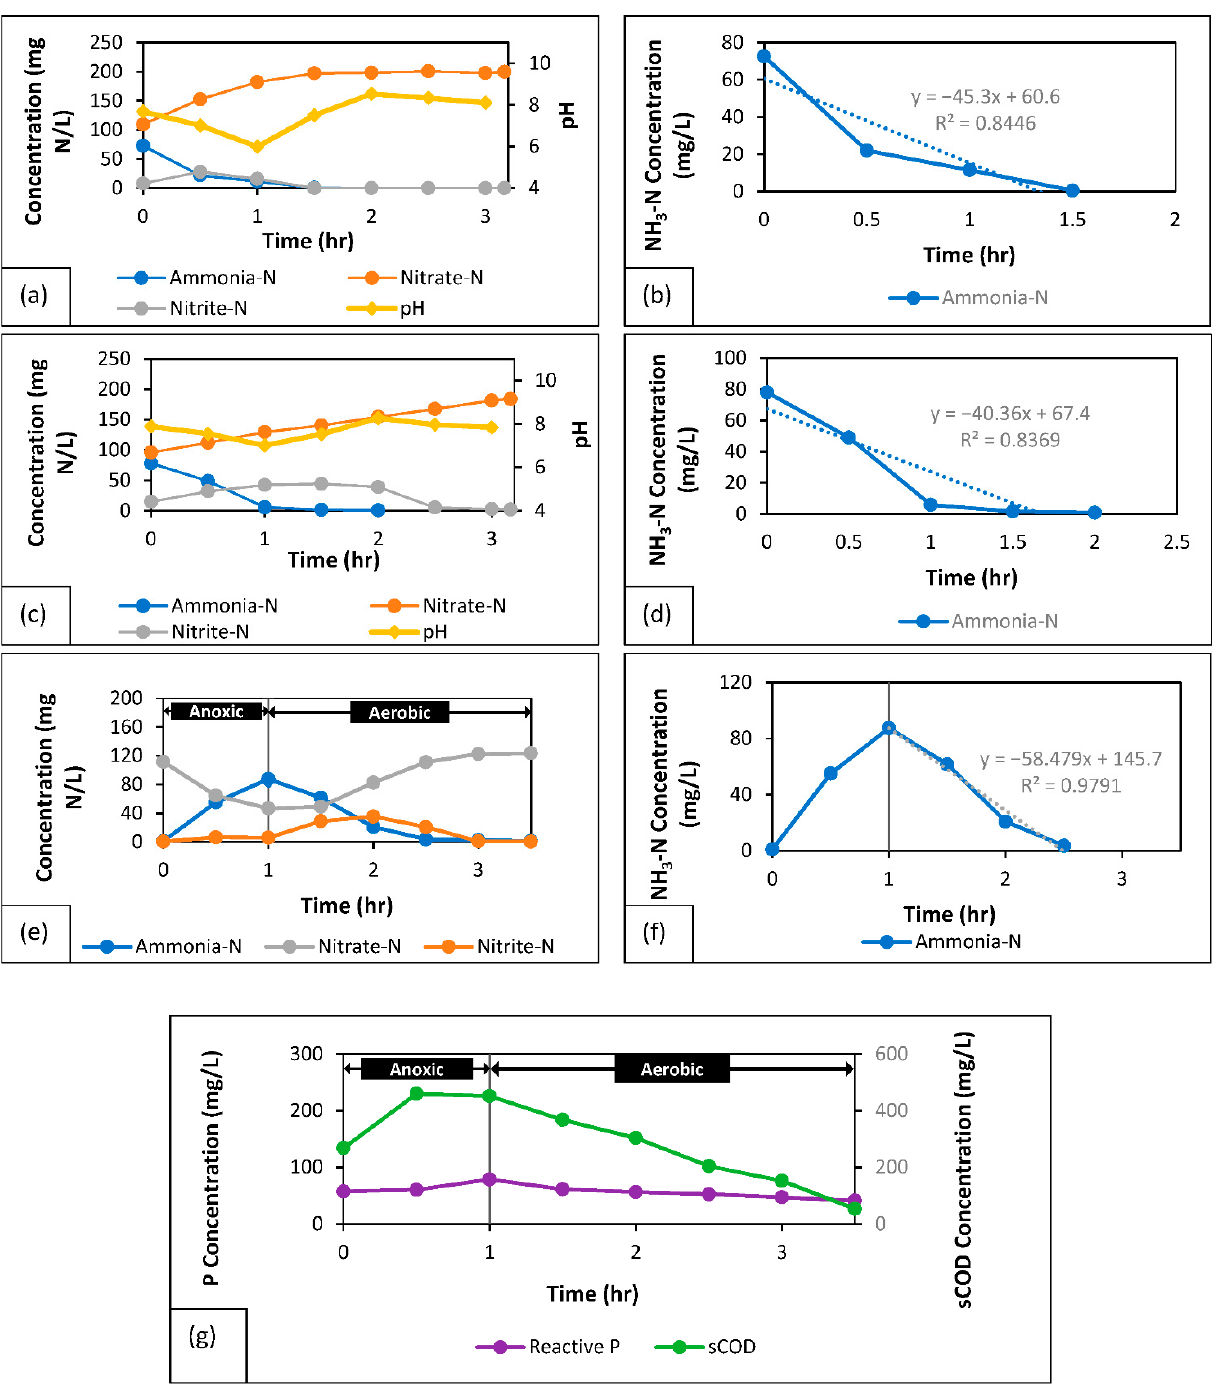
Figure 5. Nitrification profile and ammonia-nitrogen removal rate for ( a , b ) AGS-SBR-1, ( c , d ) AGS- SBR-2, and ( e – g ) AGS-SBR; ( f ) COD profile, and ( g ) Reactive Phosphorus profile for AGS-SBR-3 .